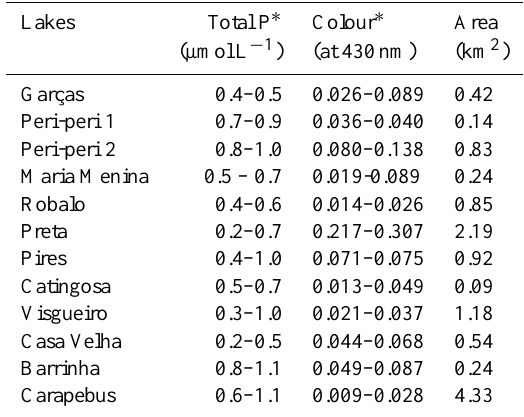
Fig. 1. Location of the studied lakes (1) Carapebus, (2) Garc¸as, (3) Peri-peri 1, (4) Peri-peri 2, (5) Maria Menina, (6) Robalo, (7) Visgueiro, (8) Catingosa, (9) Pires, (10) Preta, (11) Barrinha and (12) Casa Velha. Table 1. General characteristics of the studied